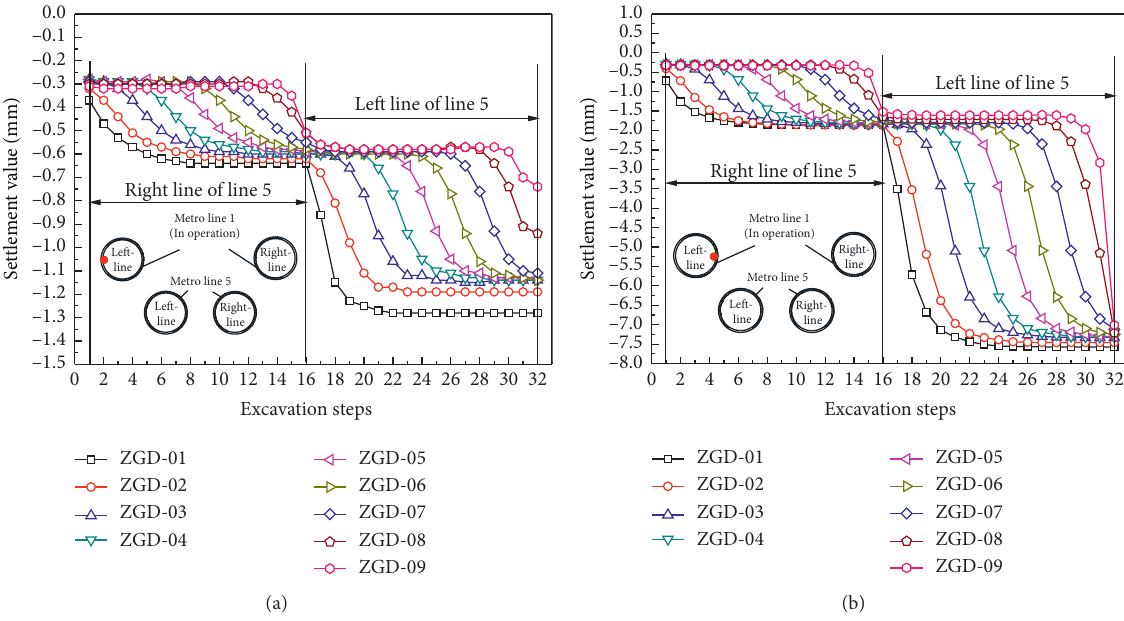
Figure 7: Settlement of left-line arch waist of line 1 caused by the construction of line 5. (a) Left-side arch waist. (b) Right-side arch 6.48 mm. The maximum settlement at the right arch waist of the left and right arch waist of right-line tunnel of line 1 is left-line tunnel of line 1 is 7.68 mm, and the maximum 3.12 mm. The maximum settlement of right arch waist of difference between the left and right arch waist is 6.40 mm. left-line tunnel of line 1 is 2.10 mm, and the maximum settlement difference of left and right arch waist is 1.28 mm. After the construction of left and right double-line tunnels of line 5, the maximum settlement at the left arch waist of right- line tunnel of line 1 is 7.75 mm, and the maximum settle- ment difference between the left and right arch waist is